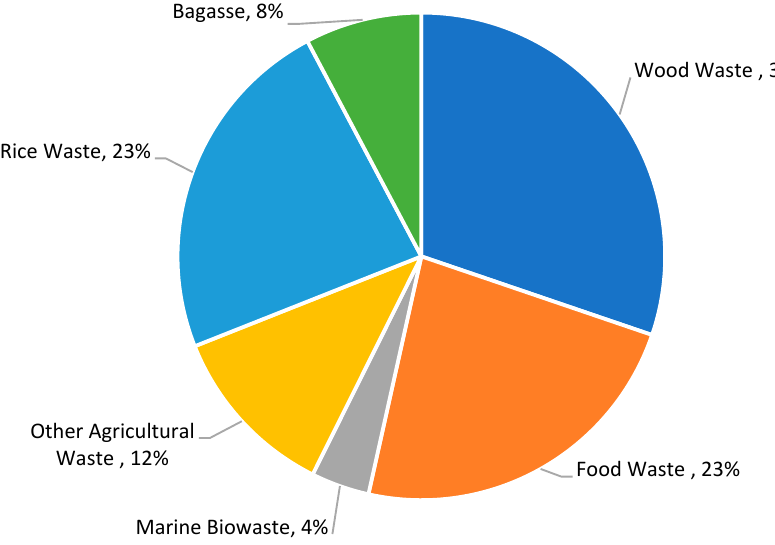
Figure 1. Biomass categories used as supplementary cementitious materials.